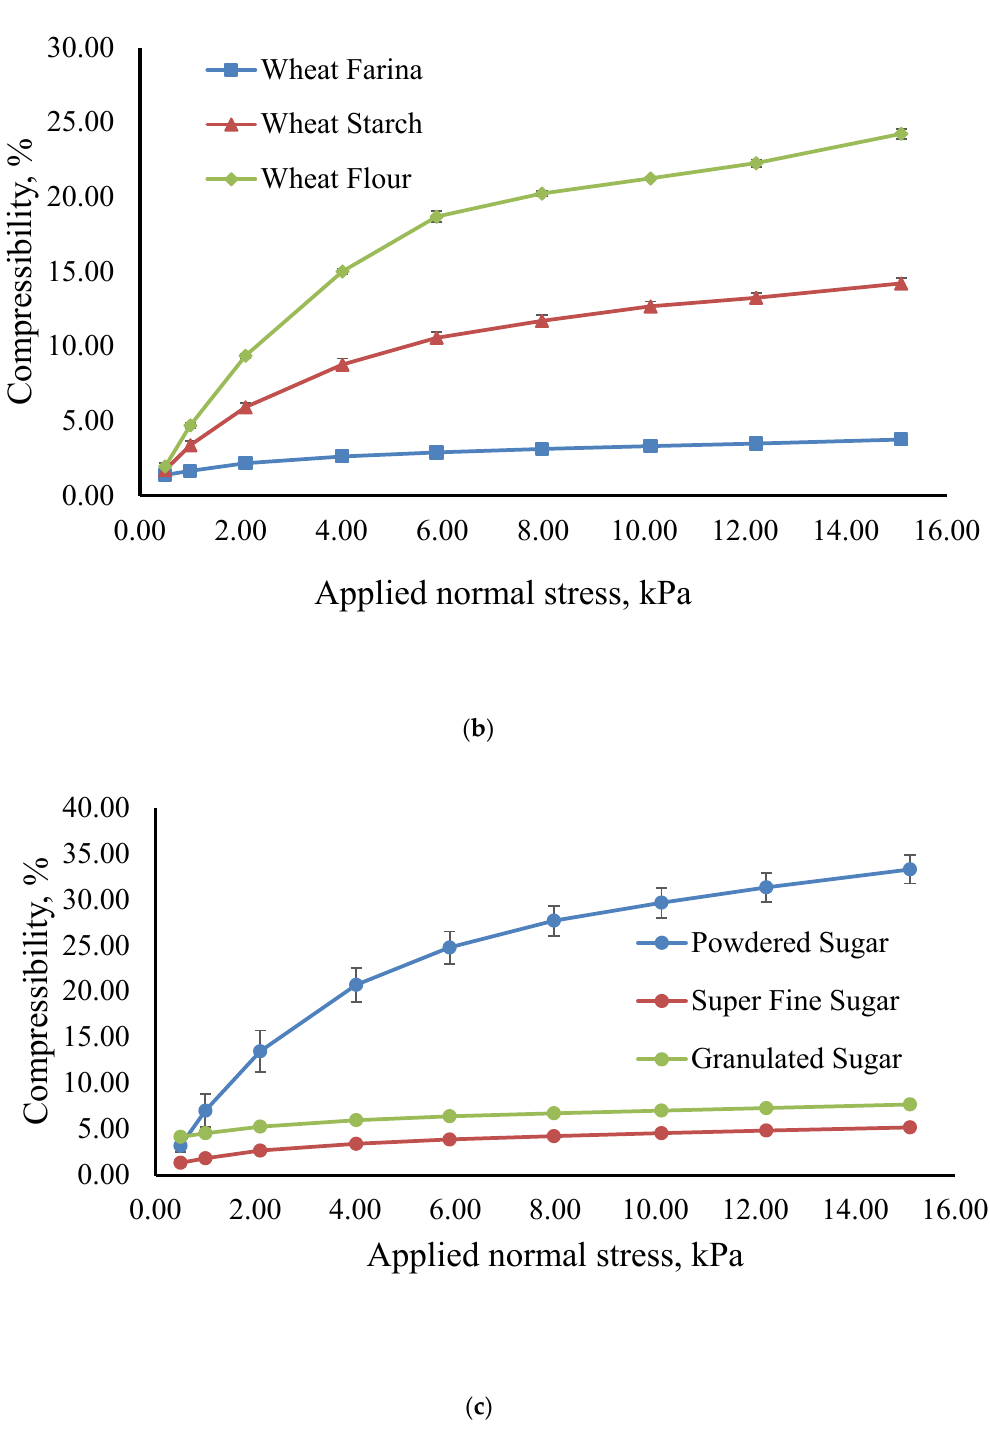
Figure 3. Effect of applied normal stress on compressibility of ( a ) corn ( b ) wheat, and ( c ) sugar powders.